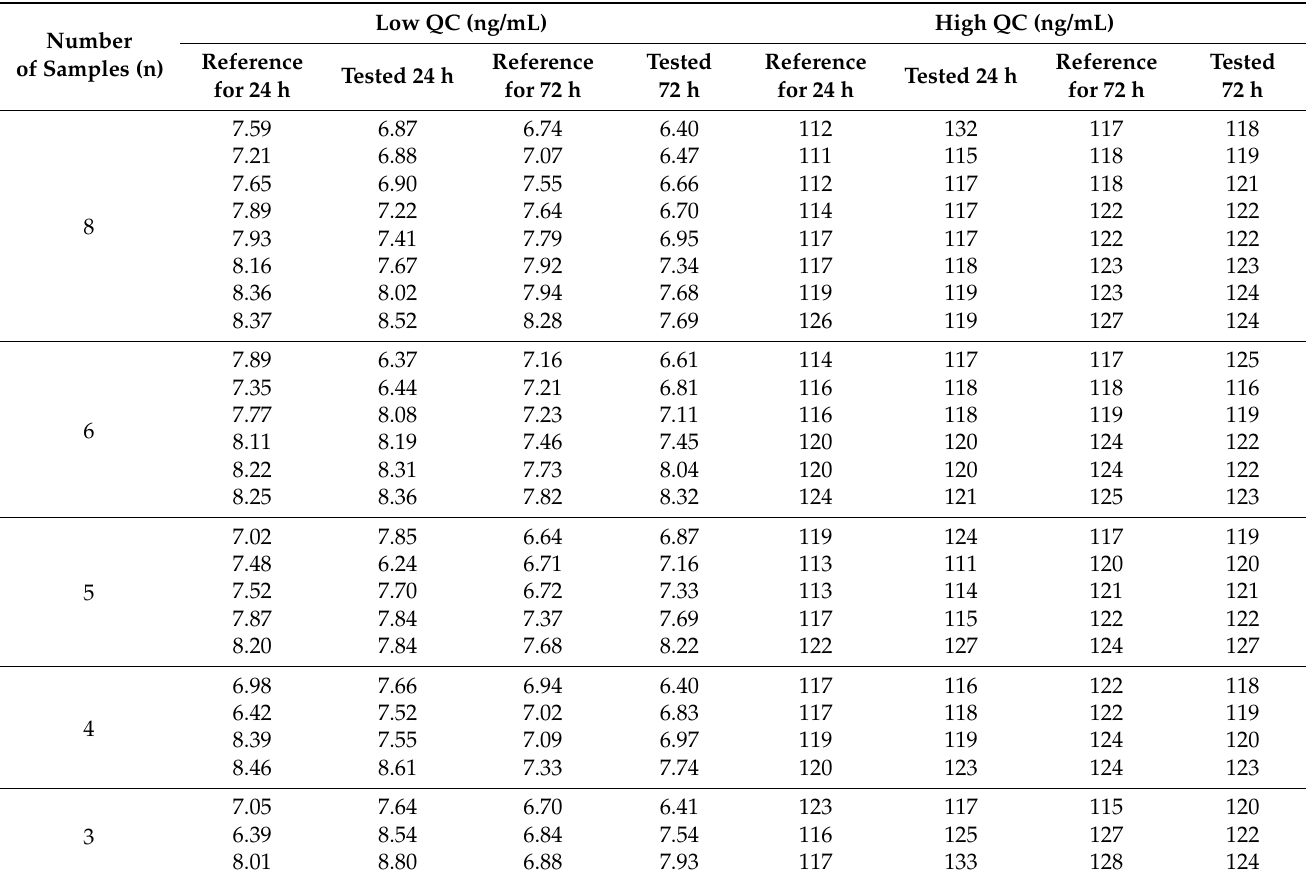
Table A2. Concentrations of O-desmethyl tramadol in human plasma during stability testing after storage for 24 h and 72 h at room temperature—low QC (nominal concentration of 7.50 ng/mL) and high QC (nominal concentration of 120 ng/mL).